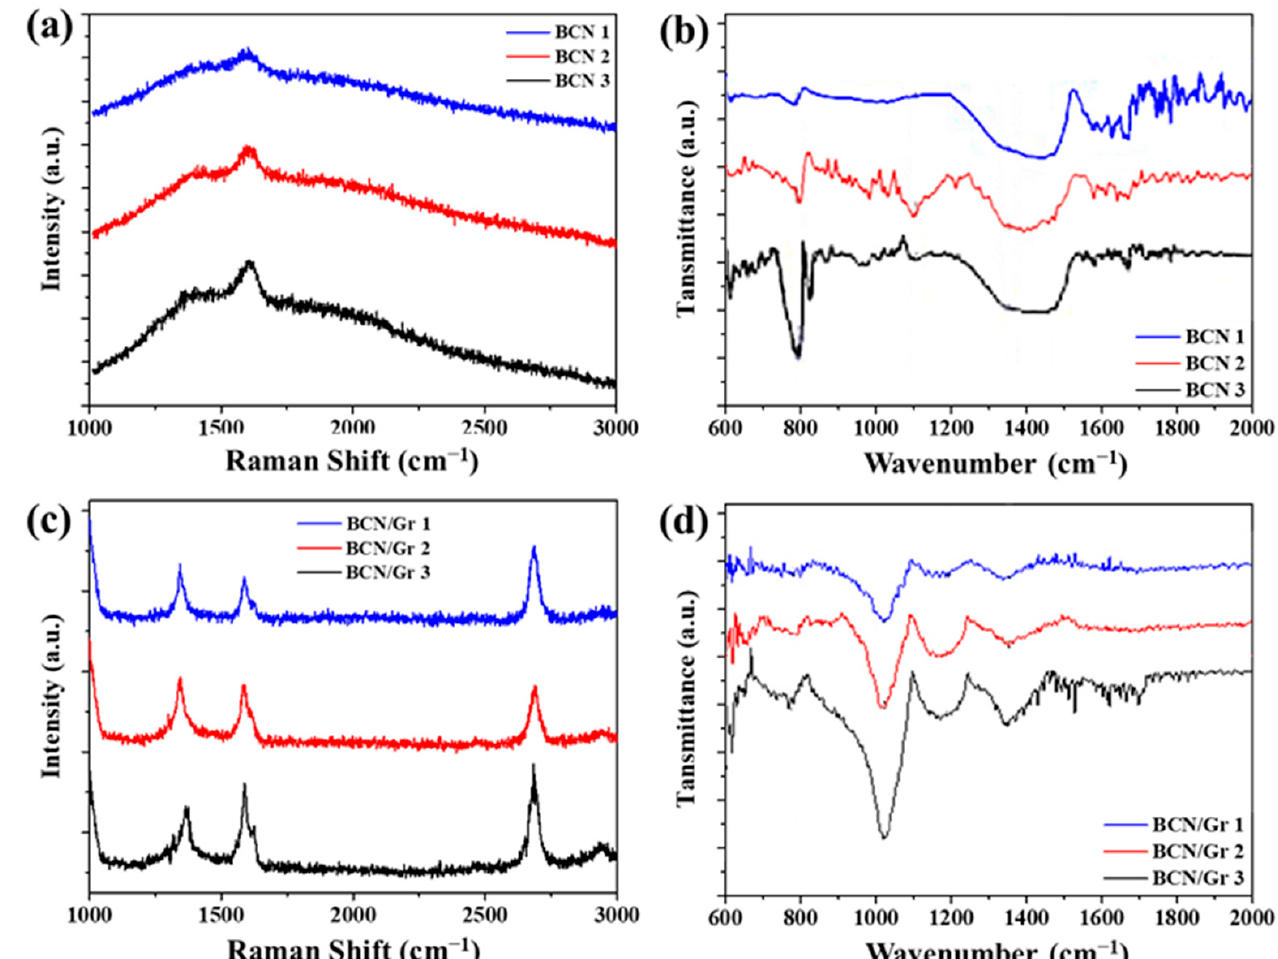
Figure 2. ( a ) Raman spectra of BCN two-dimensional films; ( b ) Infrared spectra of BCN two-dimensional films; ( c ) Raman spectra of BCN/Gr two-dimensional films; ( d ) Infrared spectra of BCN/Gr two-dimensional films.